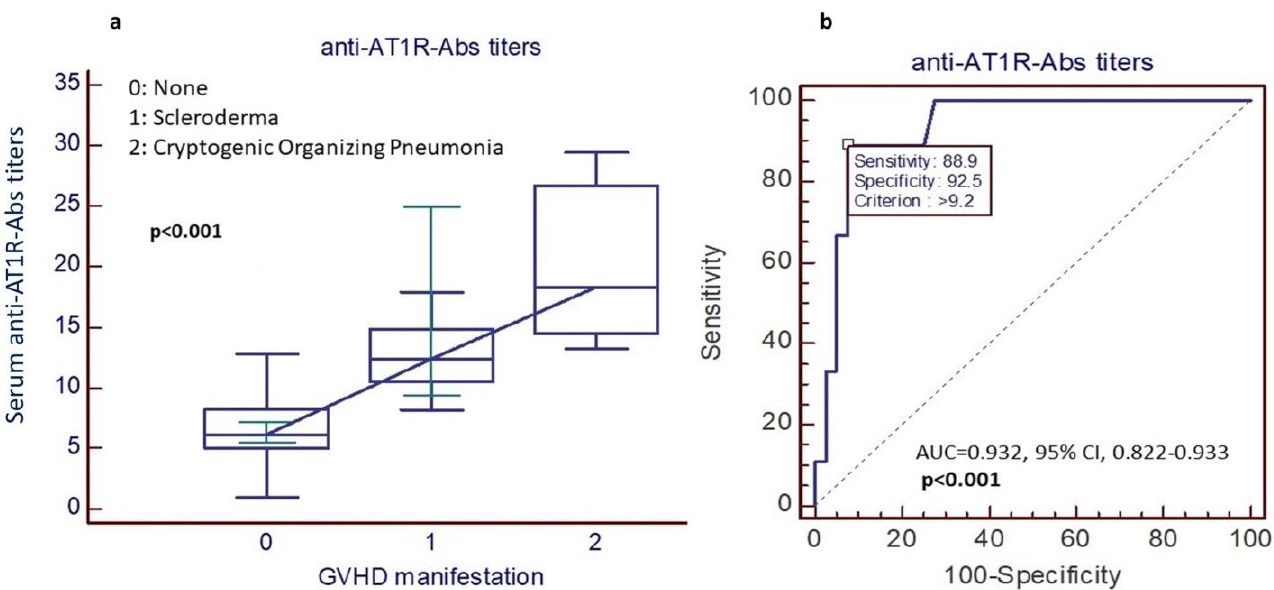
Figure 5. ( a ) AT1R-Abs and chronic GVHD with fibrotic manifestations (9 patients with scleroderma and 3 patients with COP have higher AT1R-Abs titers in comparison with patients without fibrotic GVHD manifestations), ( b ) the predictive value of AT1R-Abs titers.